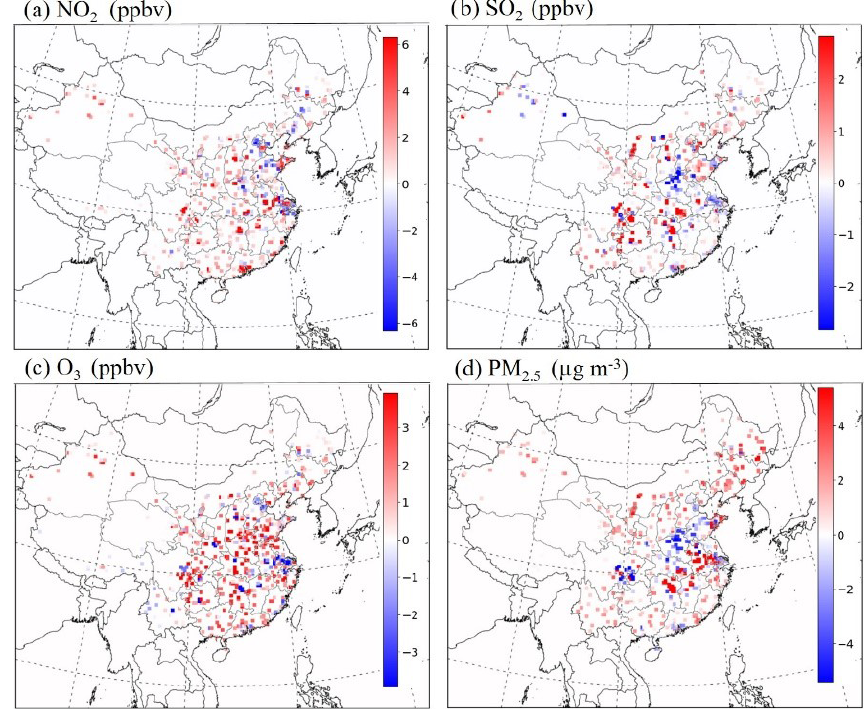
Figure 8. The MAE of NO 2 (ppbv), SO 2 (ppbv), O 3 (ppbv) and PM 2 . 5 (µgm − 3 ) concentrations based on P-Emis and